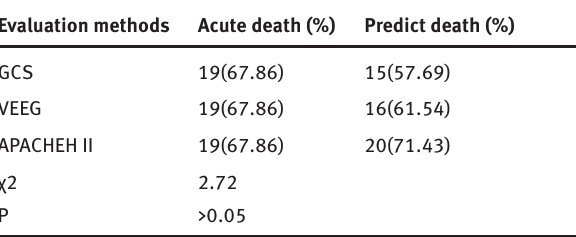
Table 4: Comparison of three methods for evaluating the prognosis of patients with cardiopulmonary resuscitation